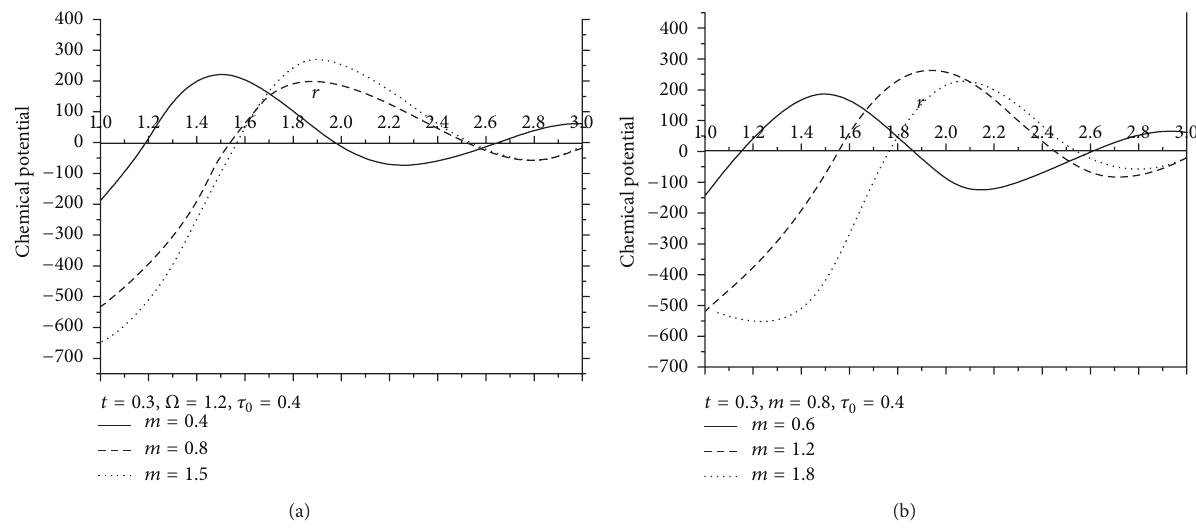
Figure 1: Variation of chemical potential 𝑃 with radius 𝑟 (thermoelastic diffusion nonhomogeneity medium).